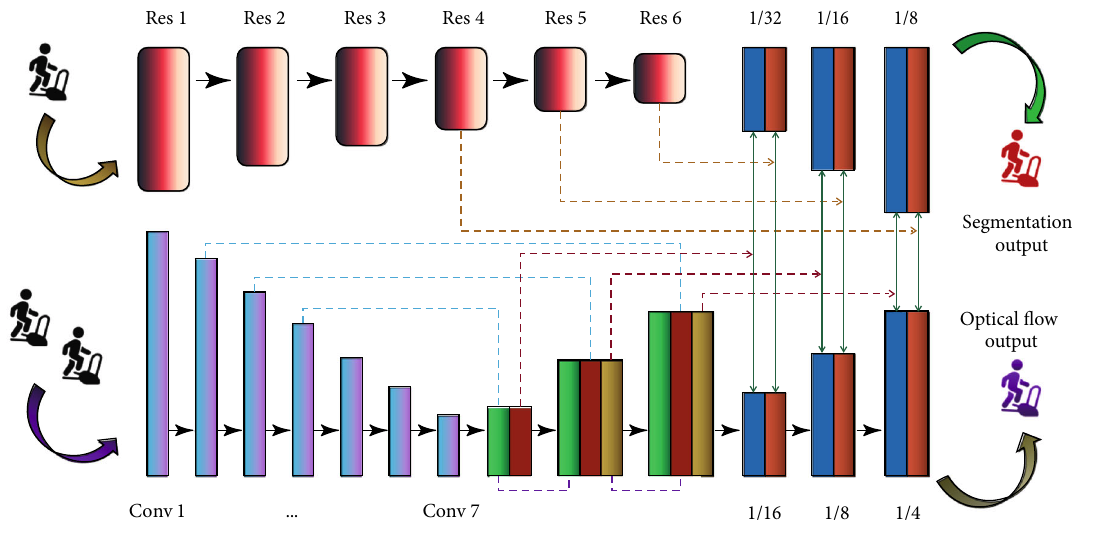
Figure 2: Network structure diagram.